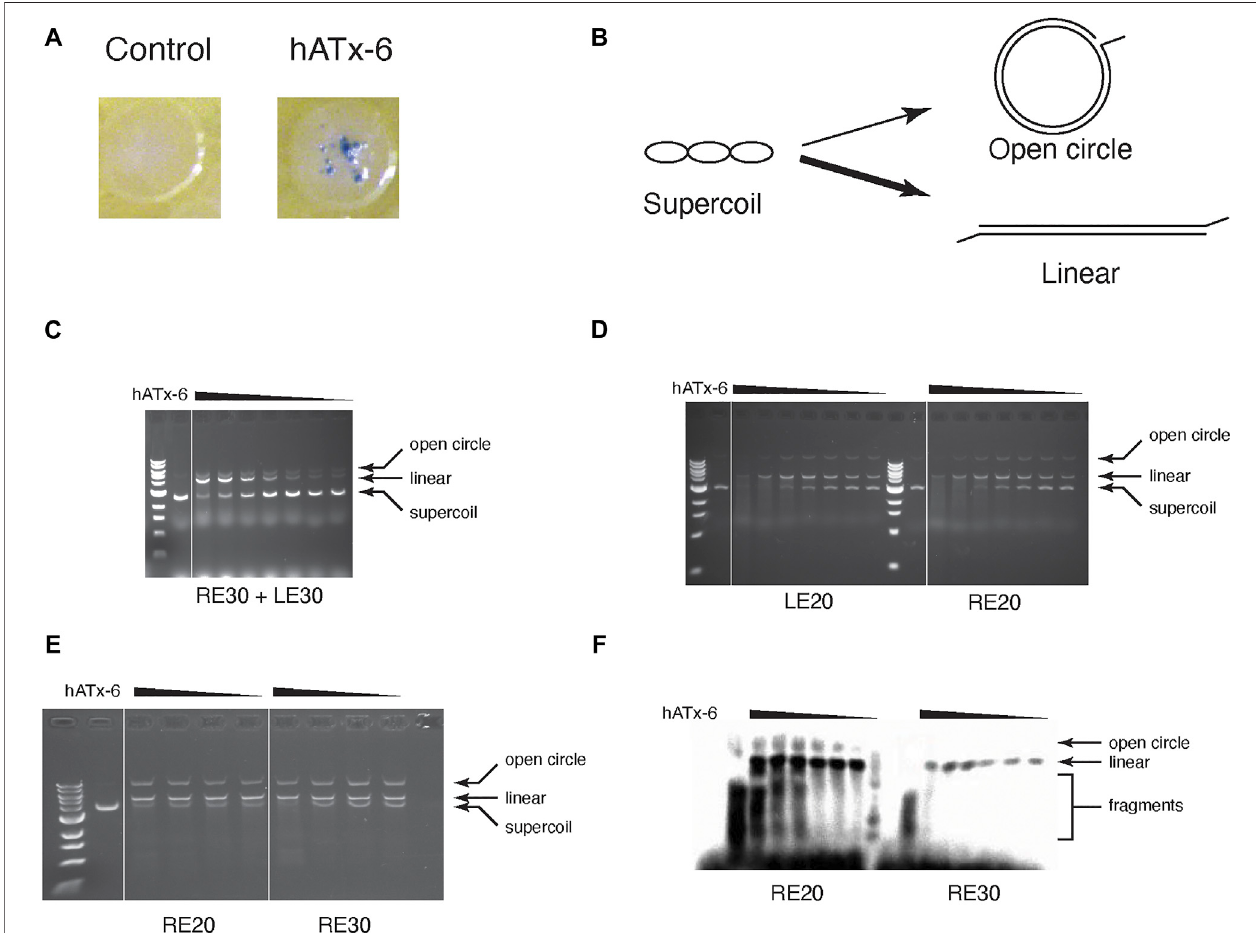
FIGURE 5 | Transposase activity assay of hATx-6. (A) Papillation assay of hATx-6 to test transposition activity in vivo . Image of a single E. coli colony expressing pMAL-c5x (empty vector control) or pMAL-c5X-hATx-6 (hATx-6) grown in rich media with X-gal (B) Schematic representation of in vitro transposase activity using a supercoiled plasmid DNA. A single nick by a transposase will result in an open circle, while double-strand cleavage or multiple nicking events will yield linearized plasmid DNA. The thickness of the arrows represents that the linearized DNA is a more frequent outcome in these reactions. (C-E) Transposition assay of titrated concentrations oftransposase (46, 36.8, 27.6, 18.4, and 9.2 μ g) with aDNA plasmid and 1 μ M ofvarious combinations of transposon ends. (C) Thereactioncontained equalconcentrationsofthe30 bprightend(RE)andthe30 bpleftend(LE). (D) Transposasereactioncontainedeitherthe20 bpleftend(LE)orthe20 bprightend(RE). (E) The reaction contained either 20 bp right end (RE) or the 30 bp right end (RE). (F) The same reaction conditions as E except that the transposon ends were labelled with Biotin and then imaged using